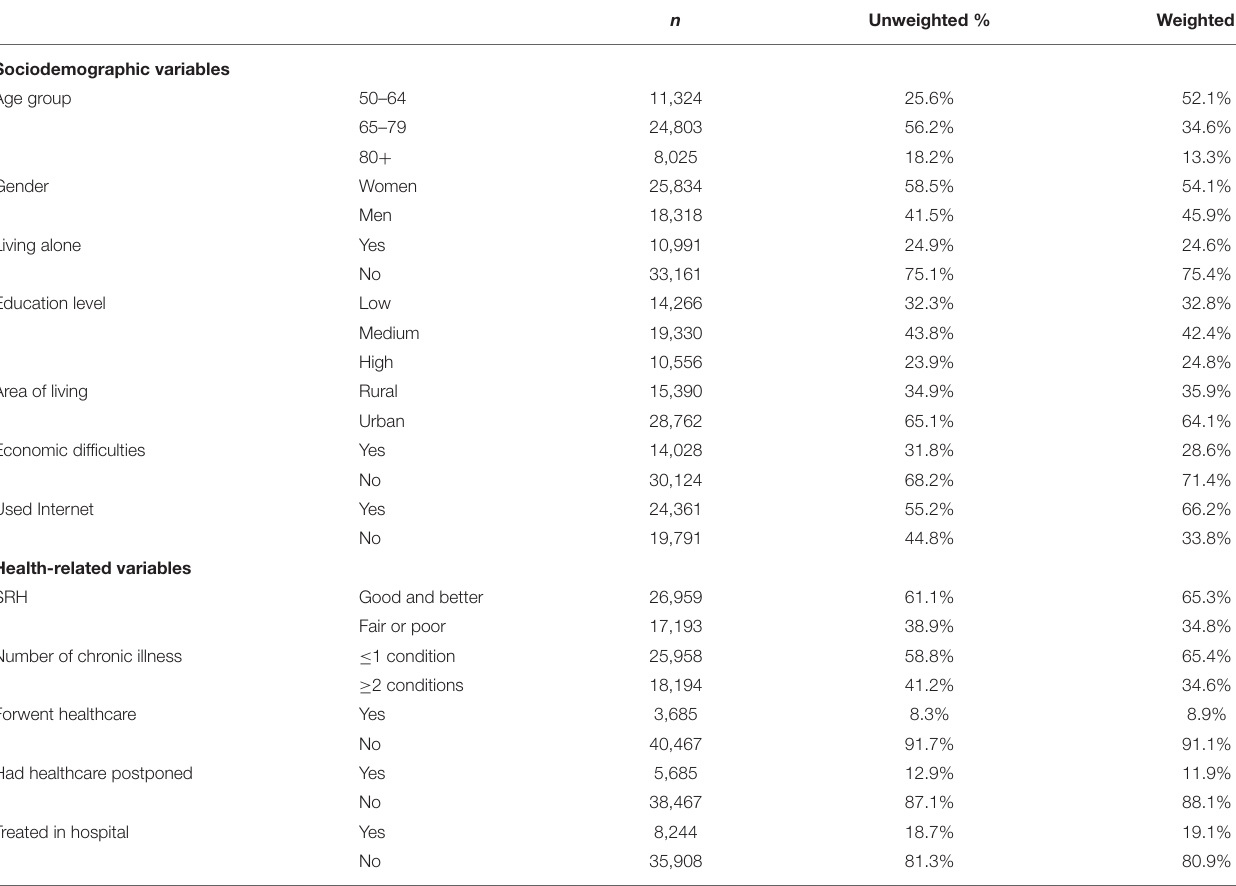
TABLE 1 | Weighted and unweighted description of the sample micro-level explanatory variables ( n = 44,152).